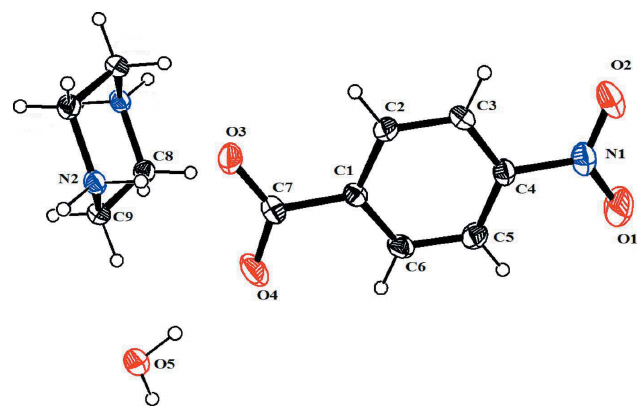
Figure 1 The molecular structure of the title compound, with atom labelling and 30% probability displacement ellipsoids. The unlabelled atoms of the piperazine-1,4-diium dication are related to the labelled atoms by inversion symmetry (symmetry operation: (cid:3) x + 1, (cid:3) y + 1, (cid:3) z +